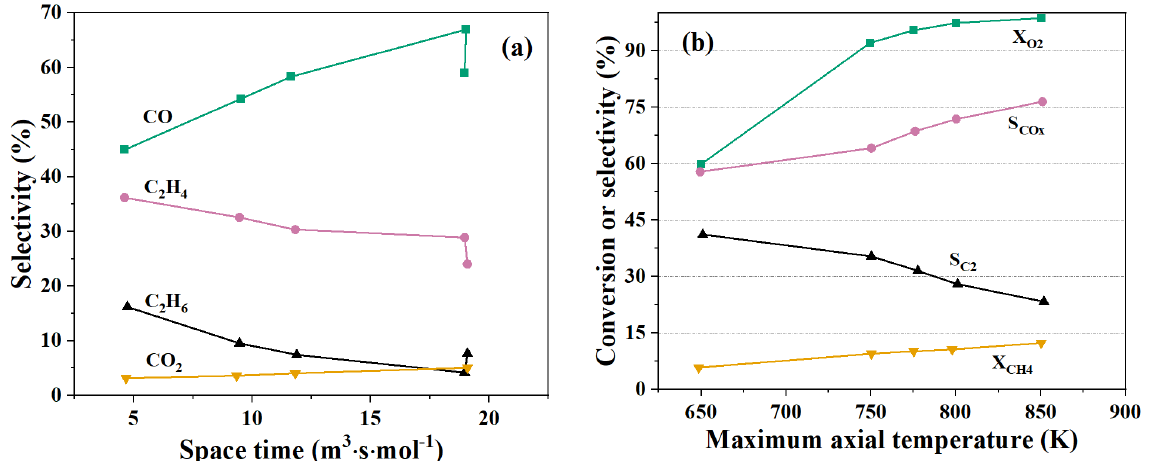
Figure 10. Effect of spatial time on carbon selectivities at 790 °C and CH 4 :O 2 :He = 10:1:0 ( a ) and effect of maximum reactor temperature on C 2 and CO x ( S ) selectivities and CH 4 and O 2 conversions ( X CH4 and X O2 ) at CH 4 :O 2 :He of 10:1:0 and spatial time of 1.9 m 3 ·s·mol -1 ( b ), at atmospheric pressure and in the absence of catalyst [96,97].